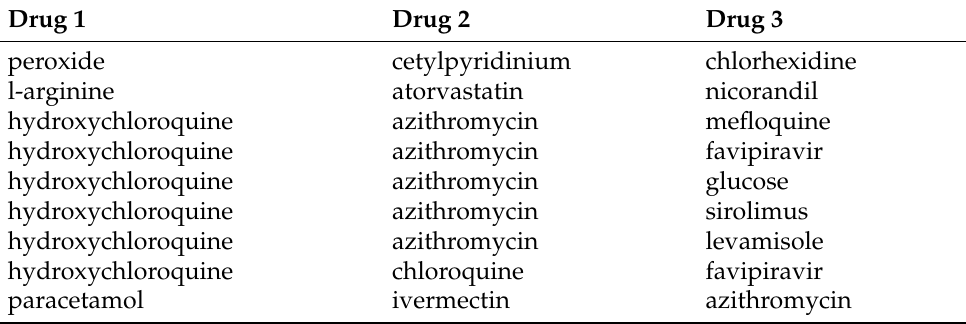
Figure 2. ( a ) Drugs and chemical entities extracted from the abstracts of the biomedical publications studying COVID-19. ( b ) Drugs and chemical entities extracted from the intervention and treatment sections of clinical trials investigating COVID-19. The list of drugs extracted from the biomedical publication ( a ) and the clinical trial records ( b ). Overlap of key drugs (ritonavir, lopinavir, favipi- ravir, hydroxychloroquine, chloroquine, and azithromycin) between the two affirms the validity of our hypothesis. Table 3. Cliques of size three detected from clinical trials association